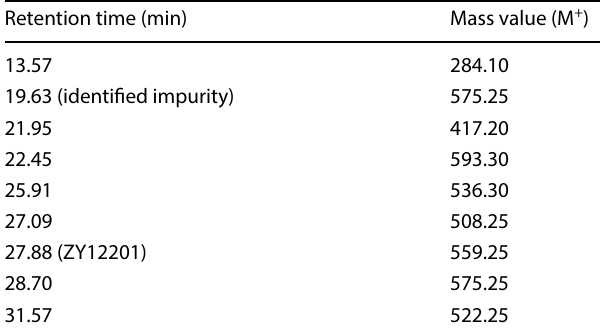
Table 5 ZY12201 and its oxidation degraded impurities mass value Retention time (min)